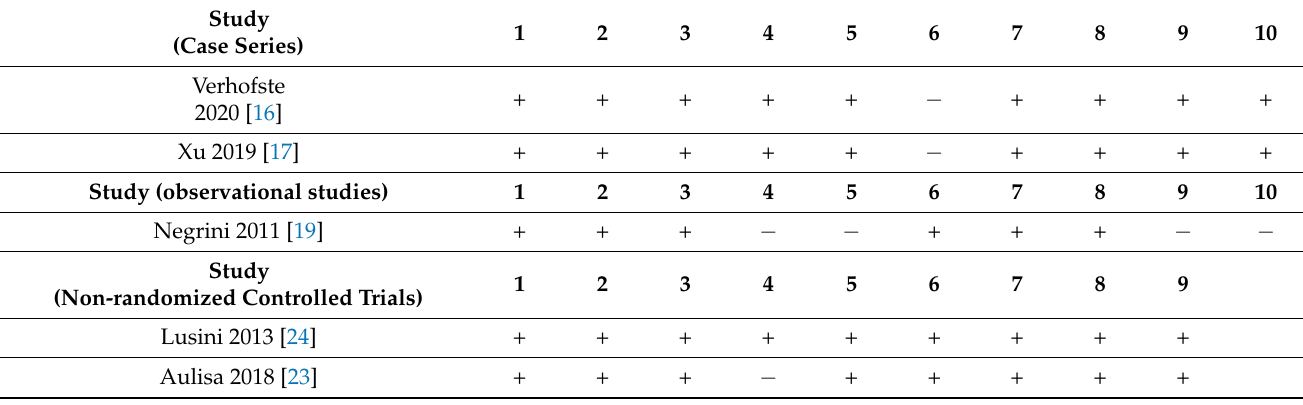
Table 2. Critical appraisal of the published studies included in the